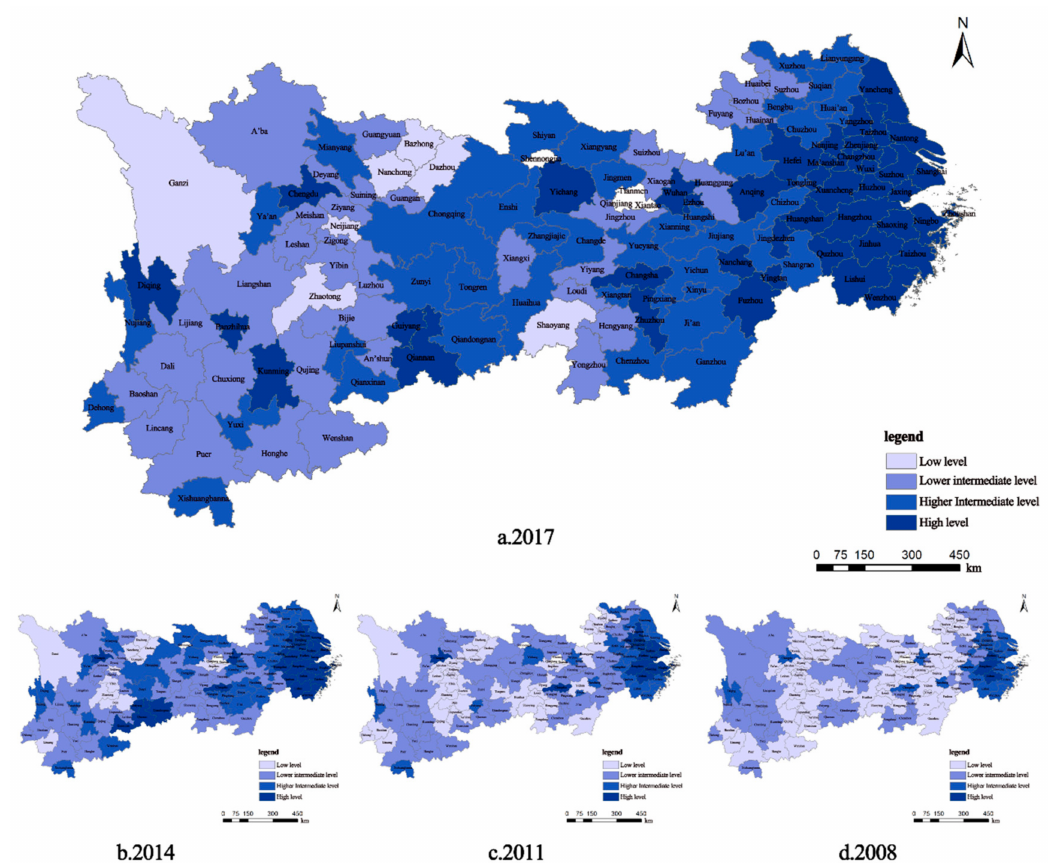
Figure 4. Spatial pattern of the green development in YREB (2008, 2011, 2014, 2017).